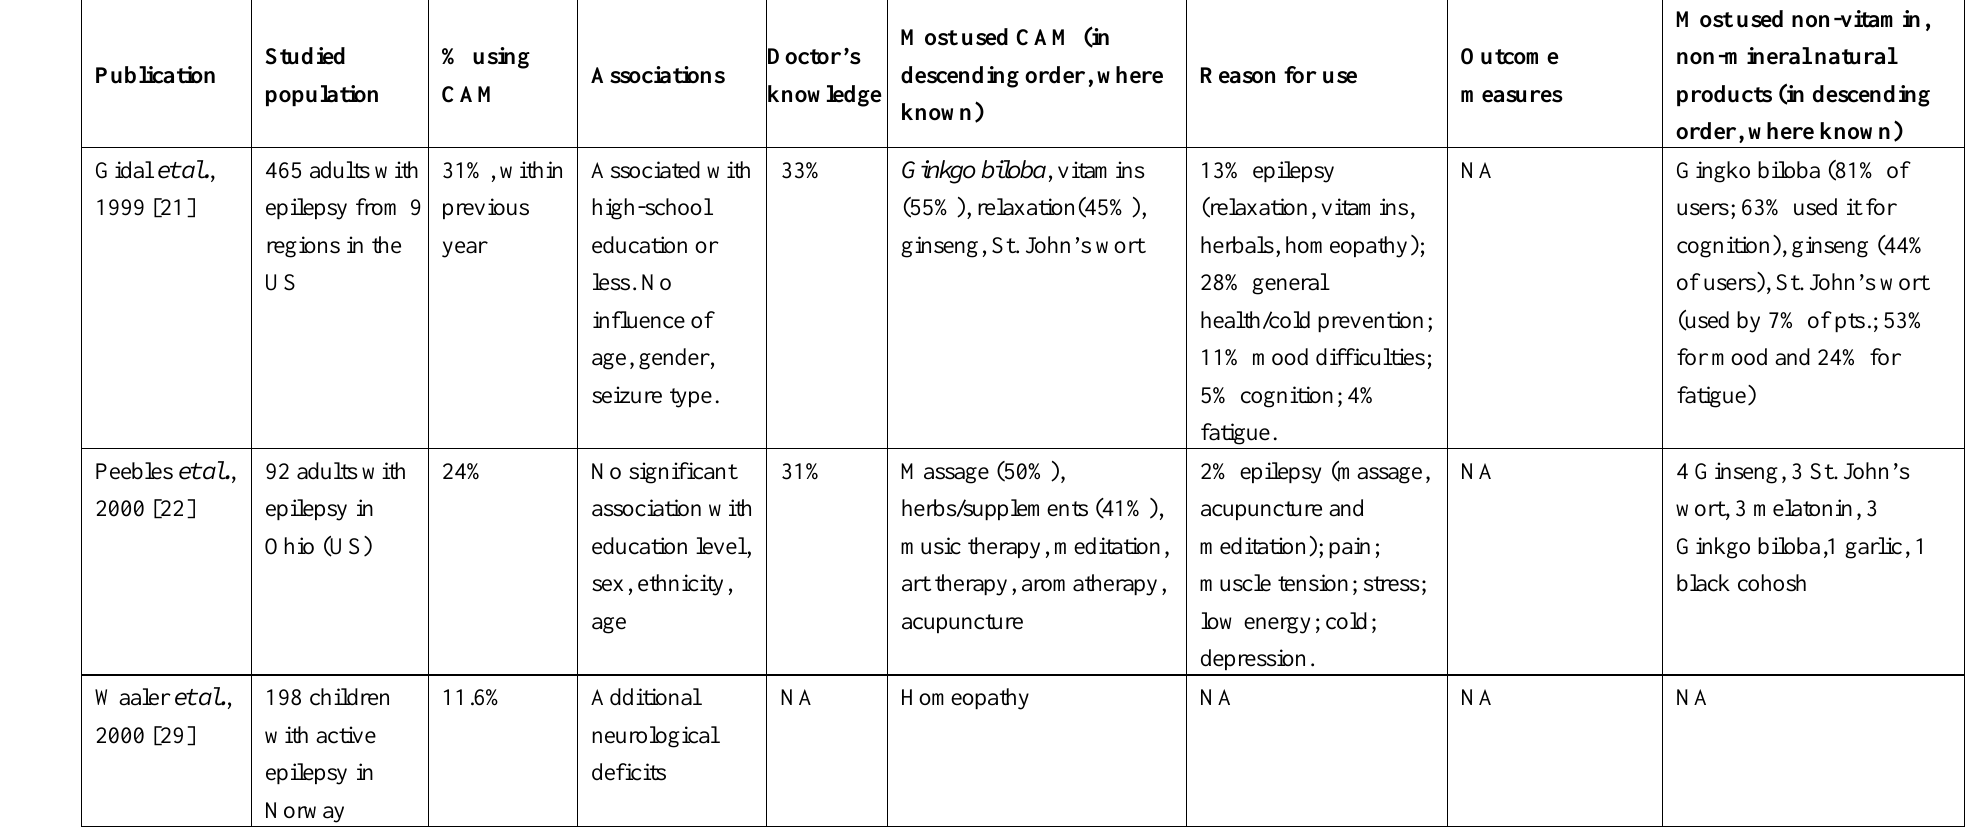
Table 1. Publications reporting on use of CAM in countries with western style medical